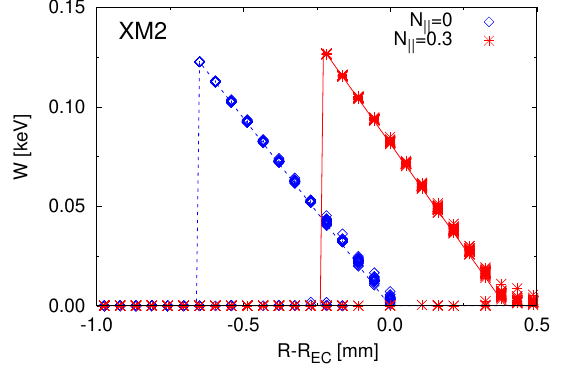
Figure 9. Same as in Figure 8 for XM2 in perpendicular propa-